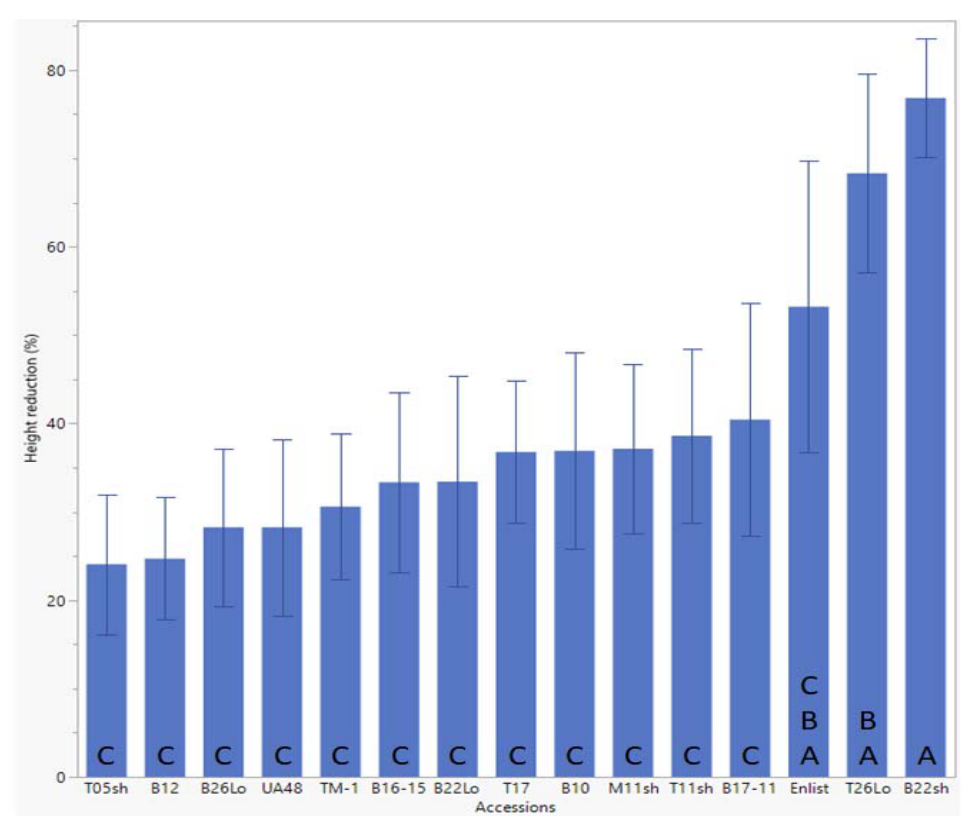
Figure 1. Palmer amaranth height reduction by cotton chromosome substitution (CS) lines at 21 days after establishment (DAE). Data were analyzed using JMP software, where p was calculated to be 0.0336. Comparison of means by a student’s t ‐ test indicated that CS ‐ B22sh performed better than most of the CS lines tested and the control lines UA48 and TM ‐ 1. Table 1. Palmer amaranth (PA) height and chlorophyll reduction values in the presence of cotton chromosome substitution (CS) lines.